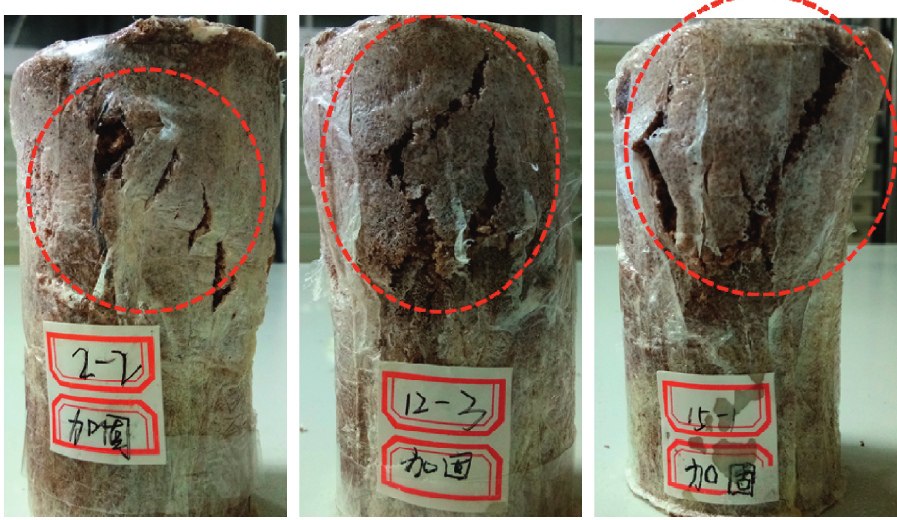
Figure 4: Splitting failure of specimens under uniaxial compression.